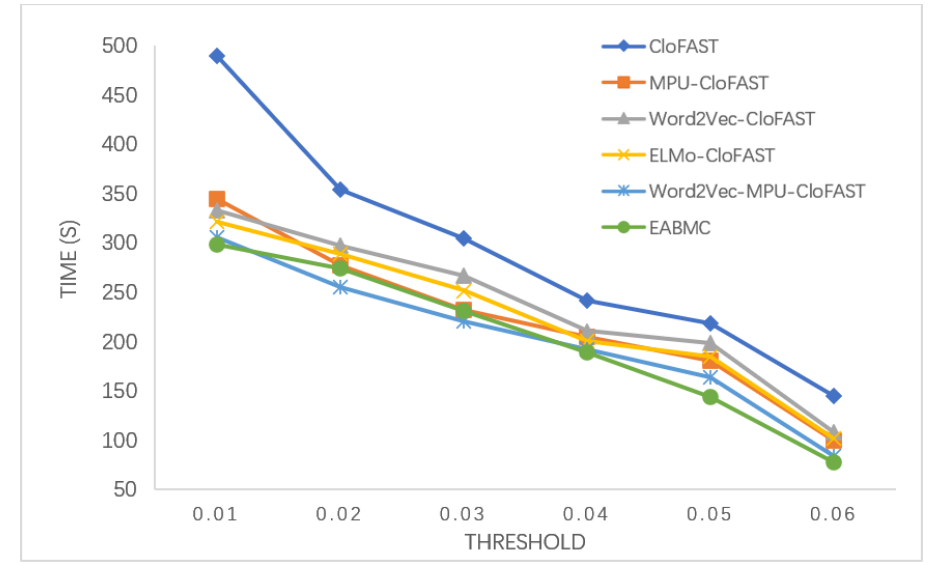
Figure 10. Running time comparison of di ff erent